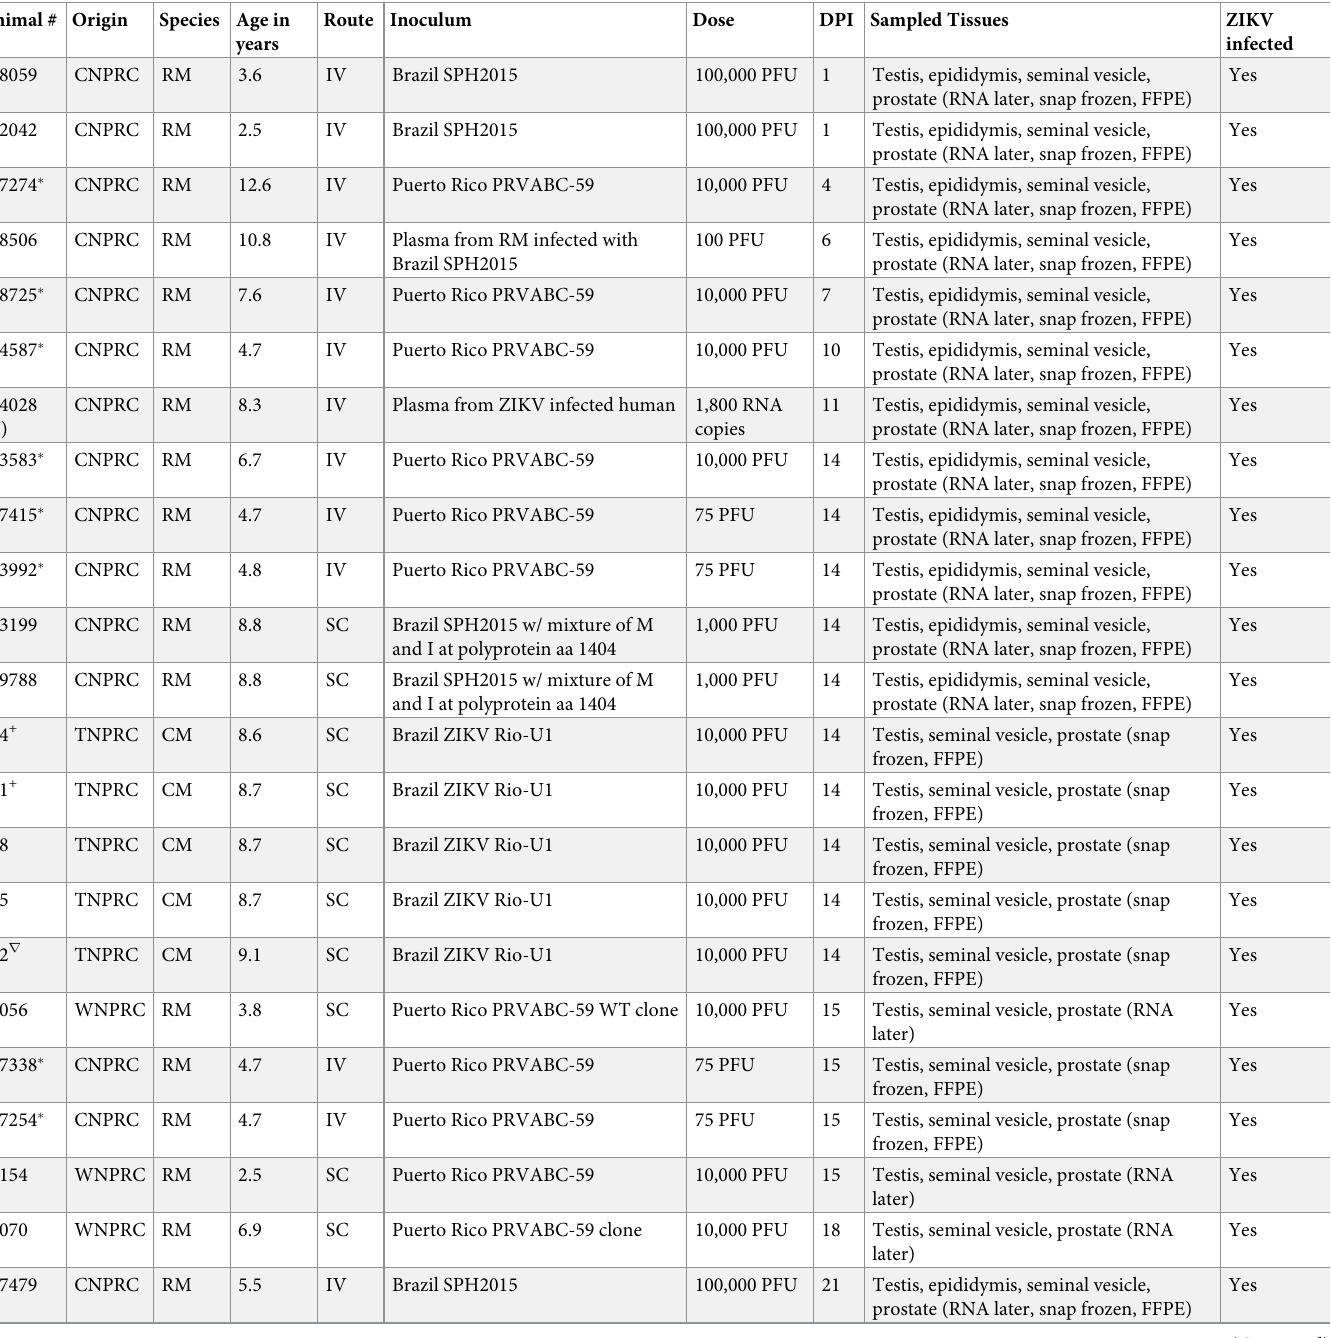
Table 1. Male macaques and the ZIKV treatments used on animals in this study. A macaque was considered ZIKV-infected if ZIKV RNA was detected in any fluid or genital tissue. � Reinoculated animals; (V) vasectomized animal; # received anti-ZIKV antibody prior to inoculation; + immune suppressed animals; r splenectomized ani- mal; (semen) frozen semen was the only submitted sample; ‘- ‘data not available; RM = rhesus macaque; CM is cynomolgus macaque; IV is intravenous; SC is subcutane- ous; ZIKV is Zika virus; PFU is plaque forming units; DPI is days post inoculation the animal was euthanized. For ZIKV strains, Brazil SPH2015 is GenBank accession KU321639.1, Brazil ZIKV Rio-U1 is GenBank accession KU926309, Puerto Rico PRVABC-59 is GenBank accession KU501215.1, PRVABC-59 clone is PRVABC-59 clone virus (pjW236-C1 P0), PRVABC-59 WT clone is PRVABC-59 clone virus (pW232-WT P0), French Polynesia Zika virus/ H . sapiens -tc/FRA/2013/FrenchPolynesia/3328